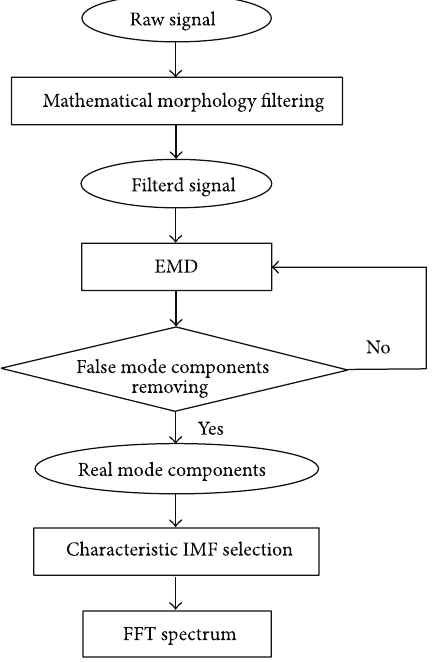
Figure 3: Flow chart of the improved EMD method.